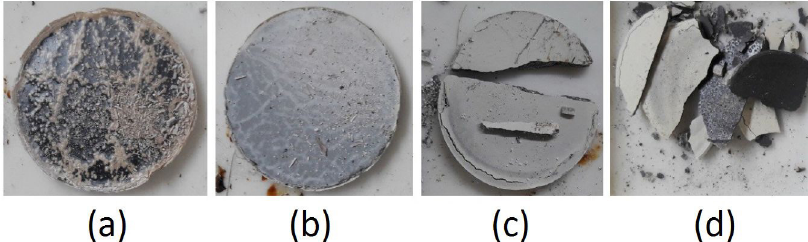
Figure 8. Photos of Zircaloy-4 samples surfaces after 1.5 h of oxidation in water at (a) 1100 °C, (b) 1200 °C, (c) 1300 °C, and (d) 1350